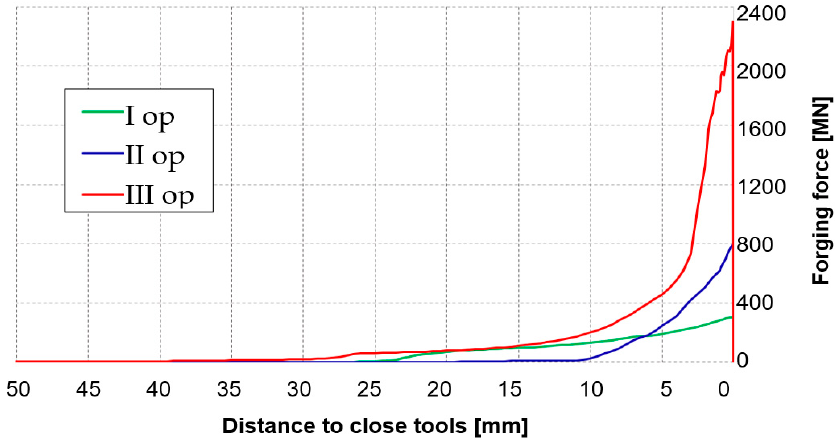
Figure 19. Courses of forging forces in operations I, II and II of forming a 60E1A6 rail.